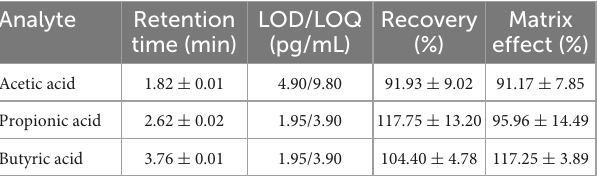
TABLE 1 Retention times, LODs and LOQs, recovery, and matrix effect rates for acetic, propionic, and butyric acids, separately. Analyte